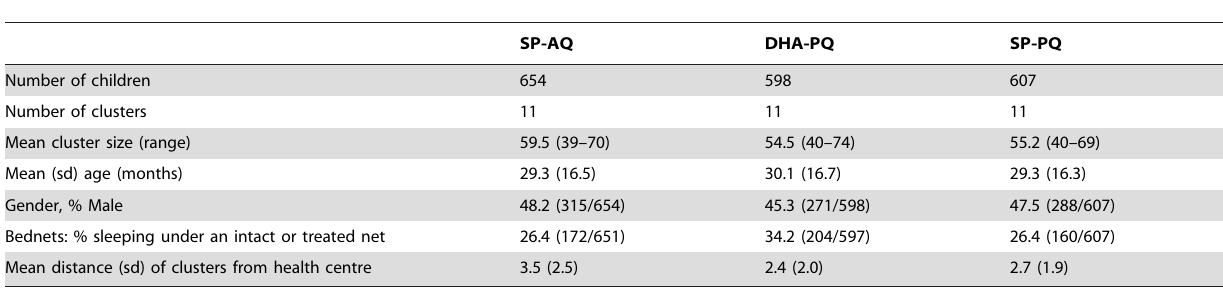
Table 1. Baseline characteristics of treatment